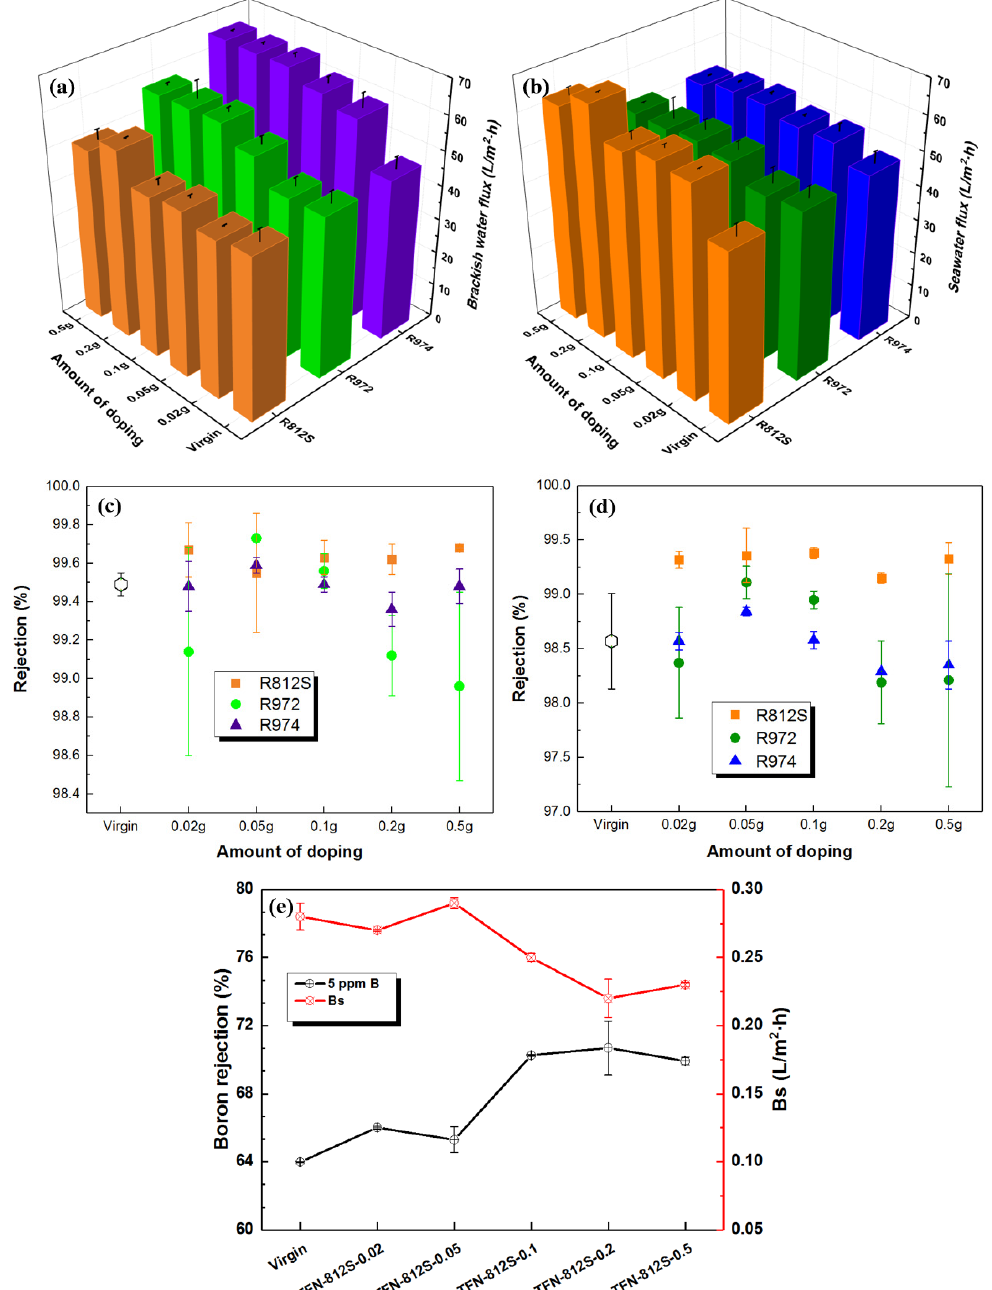
Figure 12. The measured flux of ( a ) brackish water, ( b ) seawater and salt rejection of ( c ) brackish water, ( d ) seawater of membranes doped with three kinds of NPs at different concentrations; ( e ) boron rejection of membranes doped with different concentrations of R812S NPs.